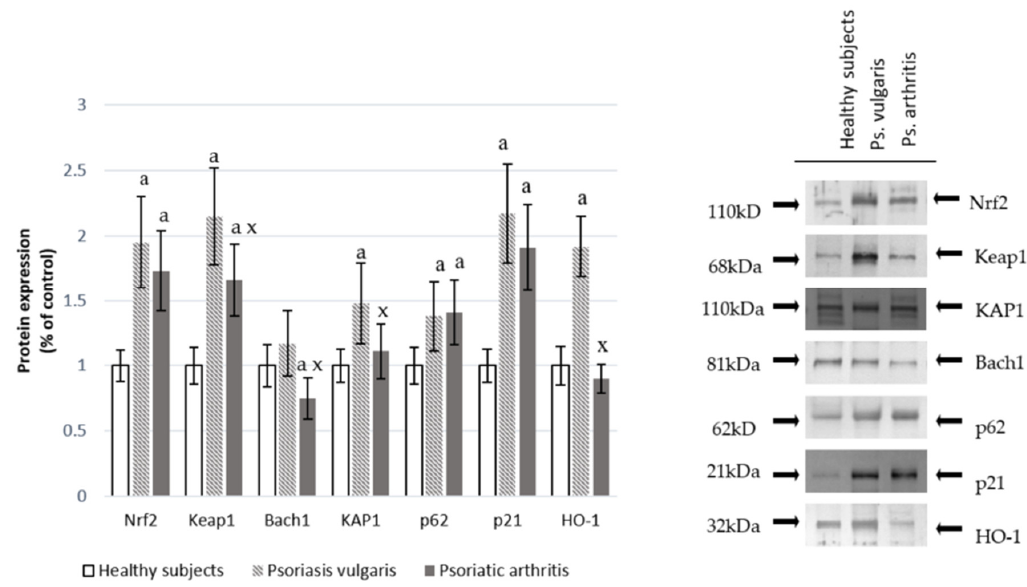
Figure 1. The level of the Nrf2 pathway factors in granulocytes from healthy subjects (n = 8) and psoriatic patients (psoriasis vulgaris (n = 16) or psoriatic arthritis (n = 8)). a p < 0.05 when compared with healthy subjects. x p < 0.05 when compared with patients with psoriasis vulgaris.